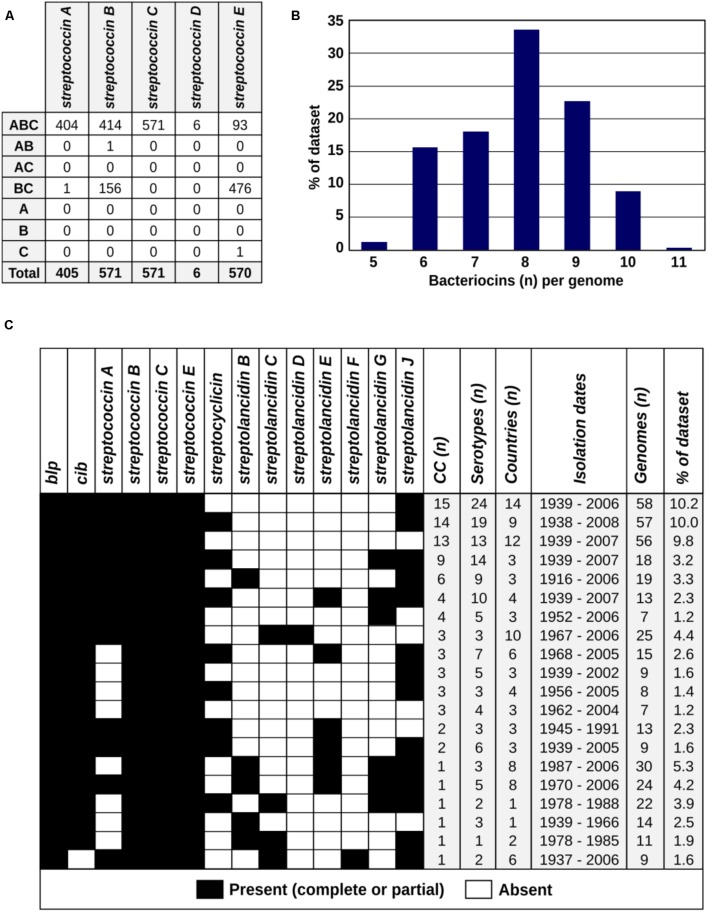
The prevalence, molecular epidemiology and co-occurrence patterns of bacteriocins within the global pneumococcal population. (A) The patterns of gene presence (column 1: A, bacteriocin; B, immunity; C, transporter) and frequency of those patterns (indicated by numbers) among streptococcins A–E within the study dataset are shown. (B) The number of bacteriocins (of any type) per genome among the 571 pneumococcal genomes is summarized. (C) Bacteriocin combinations found in >1 percent of the genomes in the dataset are presented as black and white boxes indicating the presence or absence, respectively, of each bacteriocin. The epidemiological characteristics of the pneumococci that possessed each combination of bacteriocins are summarized in the columns to the right of the black and white boxes.